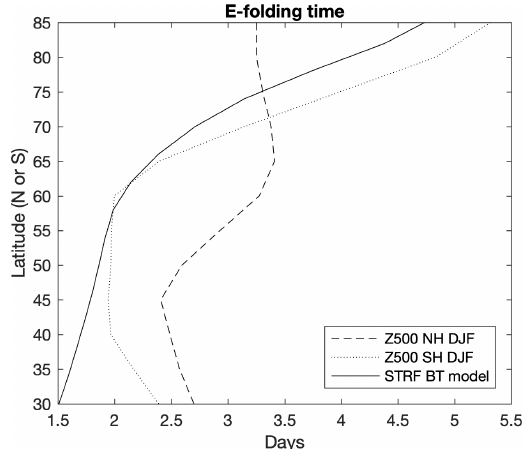
Figure 2. E -folding timescale as a function of latitude for Z 500 observational data from the NCEP2 reanalysis and streamfunction from a barotropic model